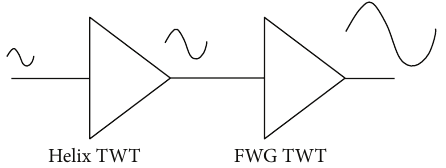
Figure 1: (Black and white) H-FWG cascaded TWT